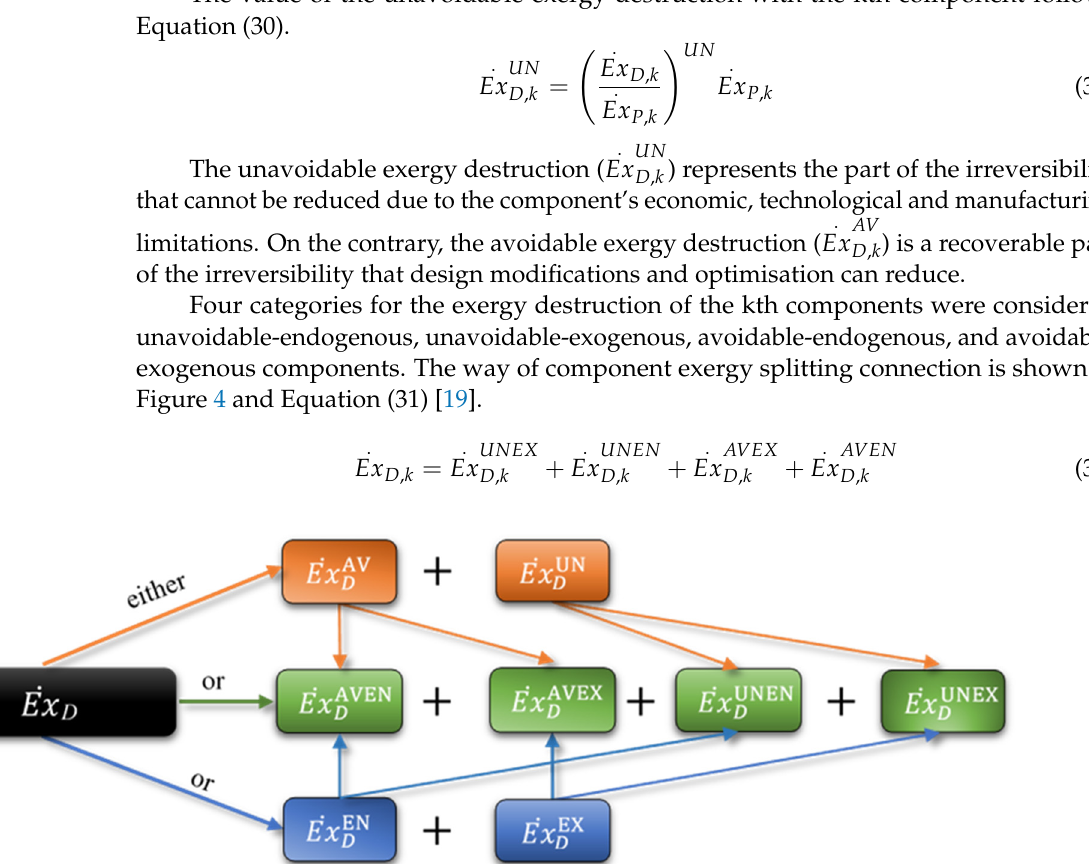
Figure 3. T-s diagram of the investigated system under different conditions: ( a ) ideal, ( b ) real, and ( c ) unavoidable.